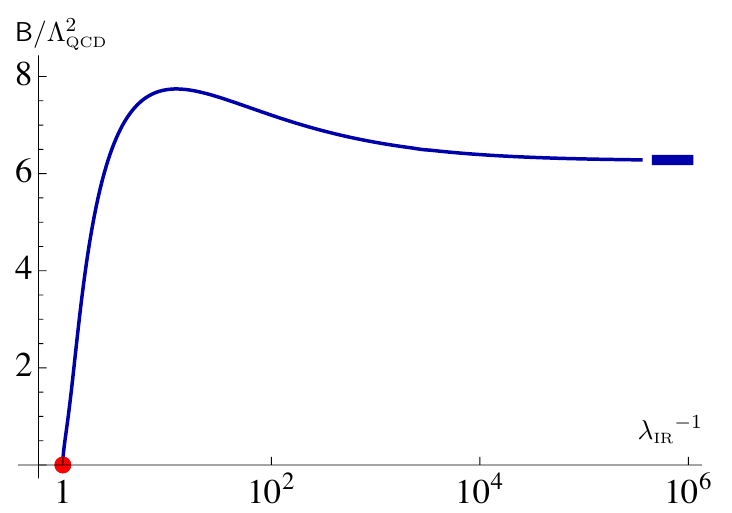
Figure 4. Magnetic field, in units of the confinement scale (2.2), as a function of the IR value of the dilaton factor e Λ . The ground state corresponds to λ The magnetic field reaches a maximum value B (thick segment) as λ → 0 IR